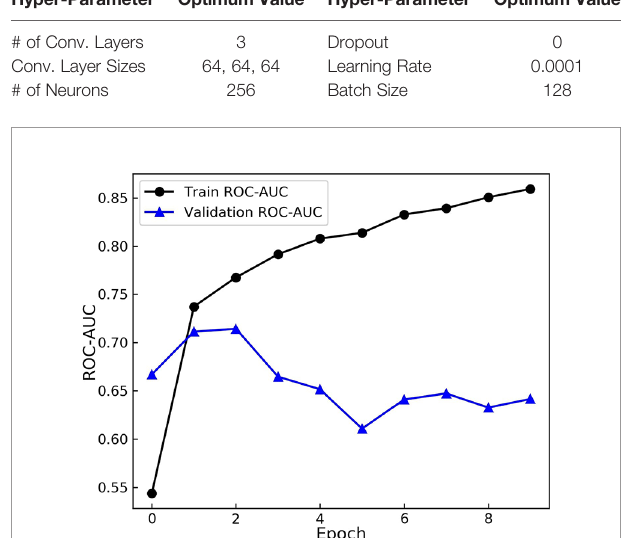
TABLE 2 | Finalized hyper-parameters from grid search. Hyper-Parameter Optimum Value Hyper-Parameter Optimum Value # of Conv. Layers